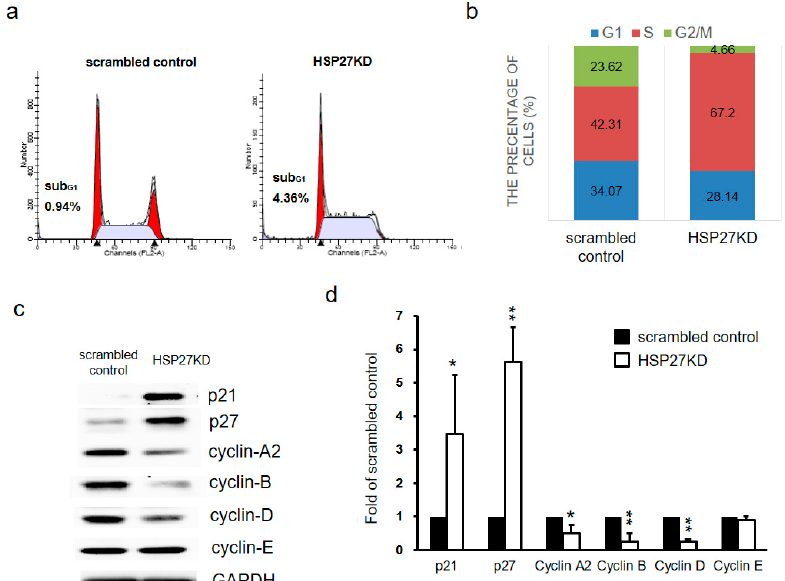
Figure 3. Targeting HSP27 influenced cell cycle distribution. ( a ) The cell cycle distribution between scrambled control and HSP27KD DLD-1 cells was determined by PI staining followed by flow cytometry analysis. ( b ) The cell cycle distribution was plotted. An increase in the S cell population was found in HSP27KD cells. ( c ) Cell cycle-regulated proteins (p21, p27, cyclin-A2, B, D, and E) were detected by western blot analyses. GADPH was the internal control. ( d ) The signal of target proteins was quantified and normalized to that of the internal control. The number of scrambled control samples was adjusted to 1. All experiments were independently repeated three times. * indicates p < 0.05, ** indicates p < 0.01.